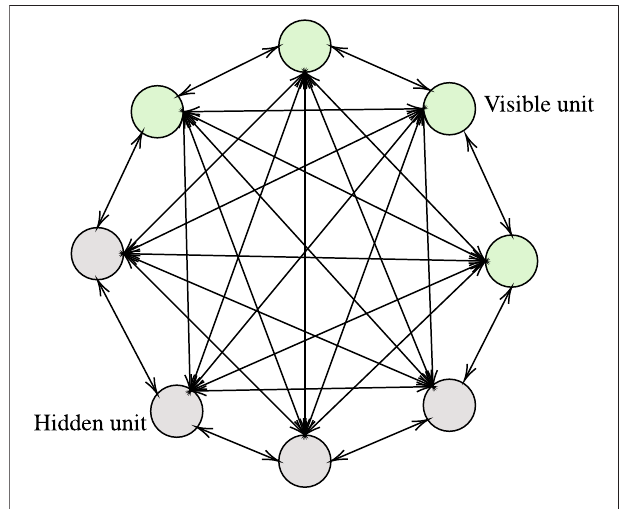
FIGURE 11 | The Boltzmann machine ’ s